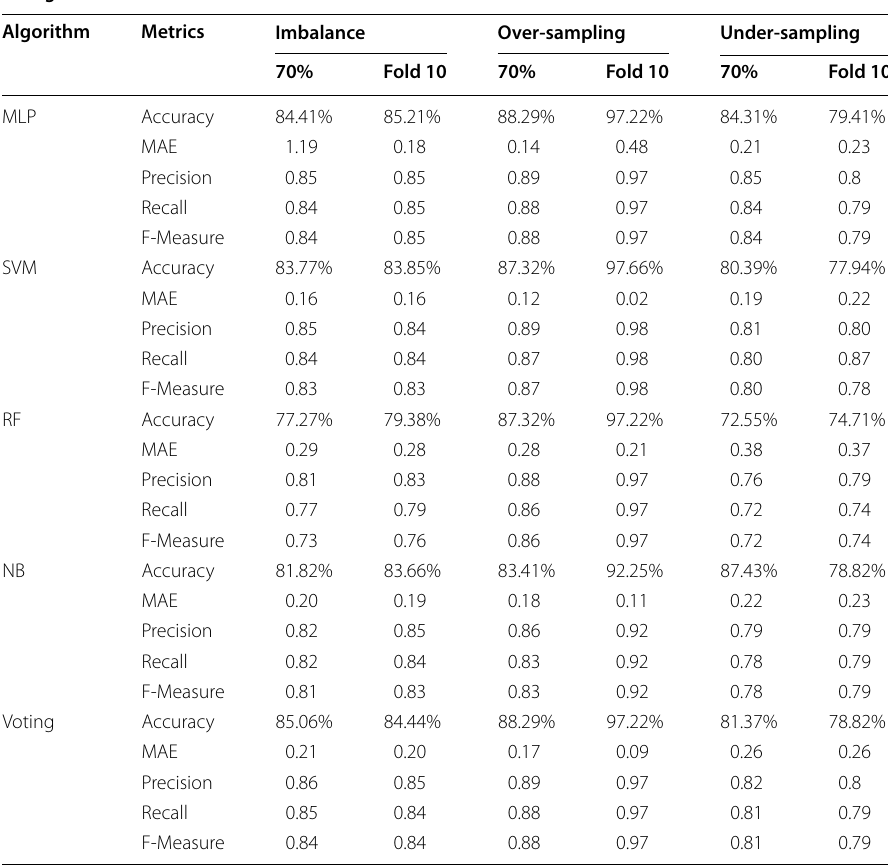
Table 10 Result of Instagram